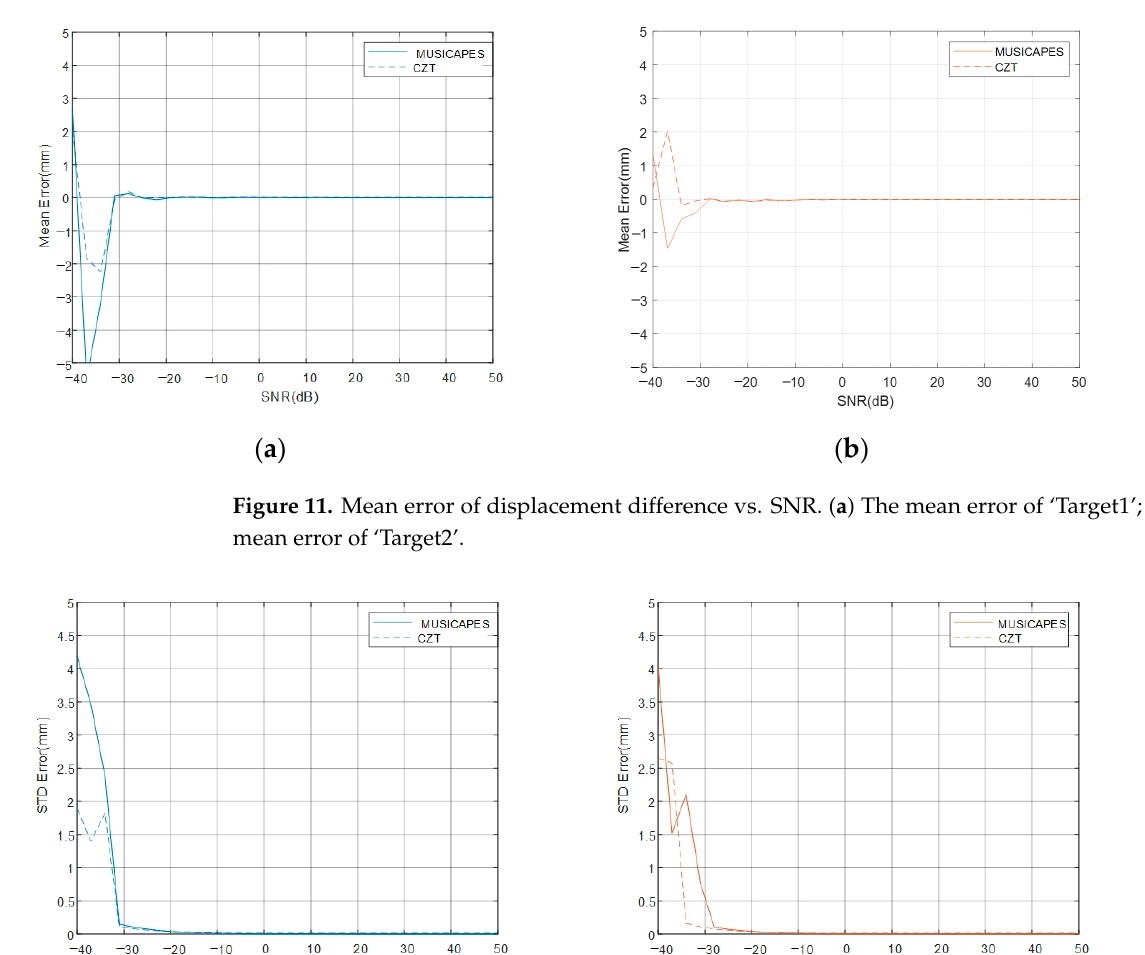
( c ) Figure 13. Multiple close targets displacement measuring experiment with an MMW MIMO radar. The radar is mounted on a tripod and connected to a laptop computer via a USB3.0 hub. ( a ) Two trihedral reflectors are placed at the end of a table. The left one is still and the right one can be moved on a sliding platform. The azimuth distance between them is 1.2 m; ( b ) the TI AWR2243BOOST is mounted on the TI DAC1000 EVM. ( c ) The right reflector is on the sliding platform which can be